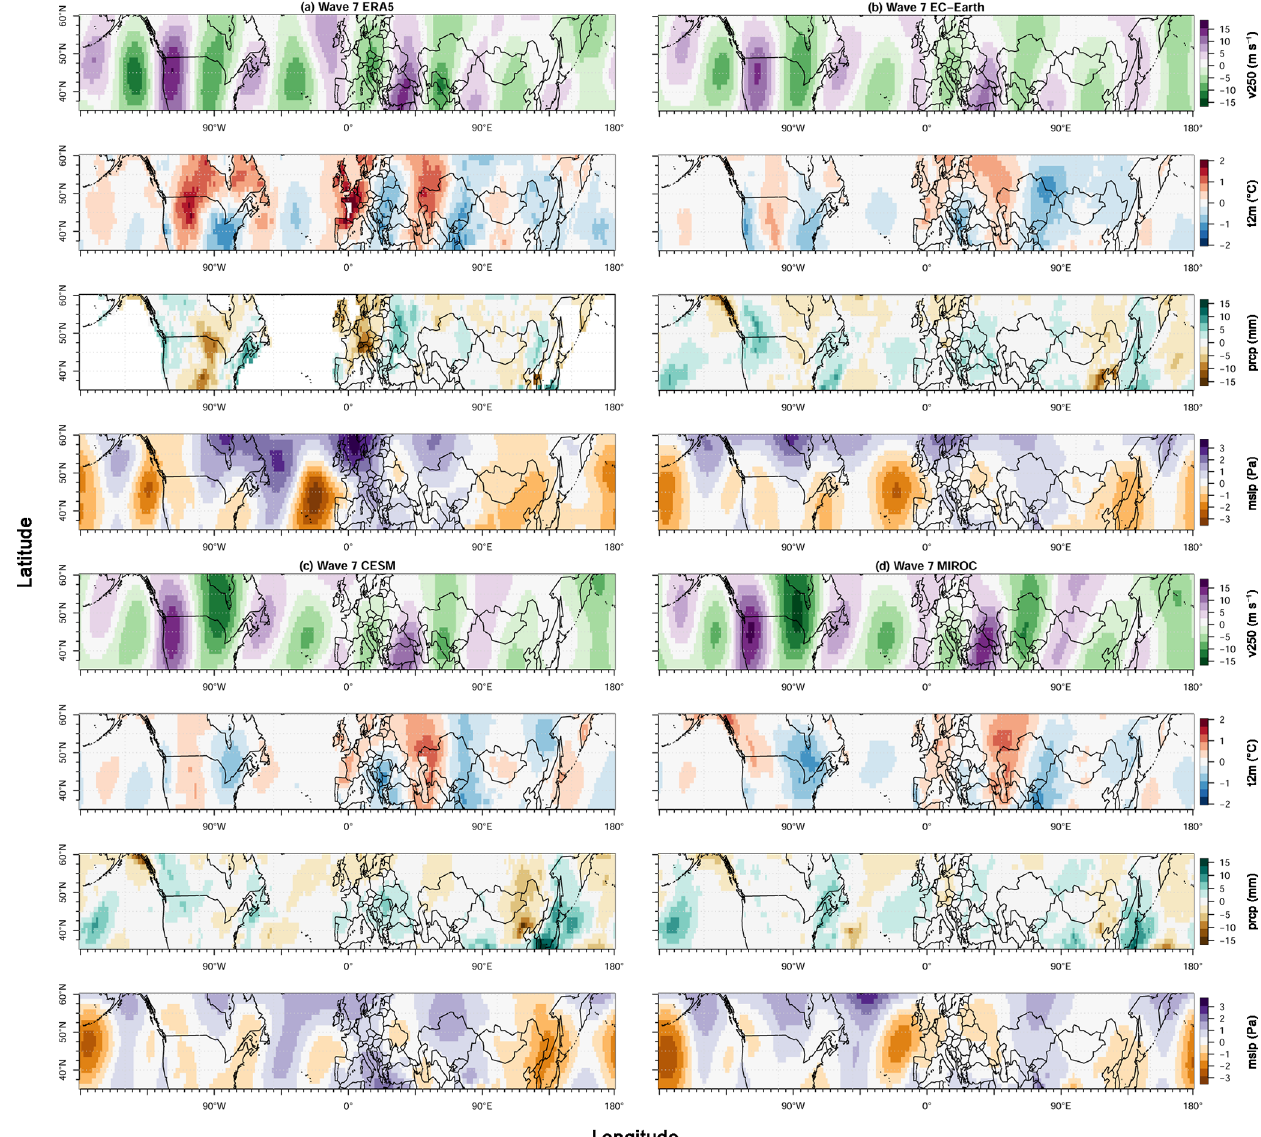
Figure 4. Composite anomaly plots of weeks with high-amplitude wave-7 episodes for meridional wind velocity at 250hPa (v250, absolute field), near-surface temperature (t2m, anomaly), precipitation (prcp, anomaly), and sea level pressure (mslp, anomaly) in ERA5 (a) , EC- Earth (b) , CESM (c) , and MIROC (d) based on the AISI control